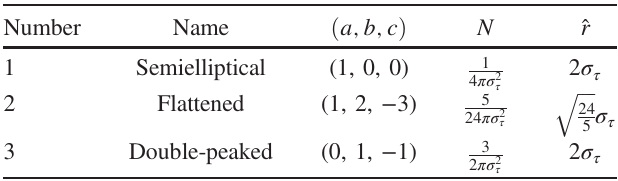
TABLE II. Polynomial distributions inserted into Eq. (7).